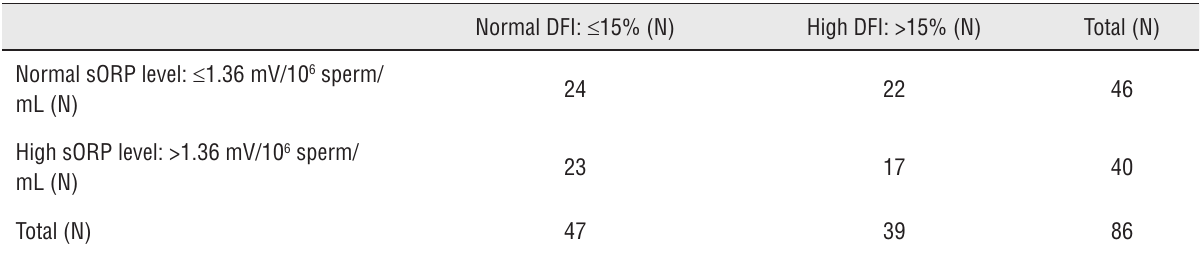
Table 3 - 2x2 table of dichotomized sperm DNA fragmentation index (DFI) and static oxidation-reduction potential